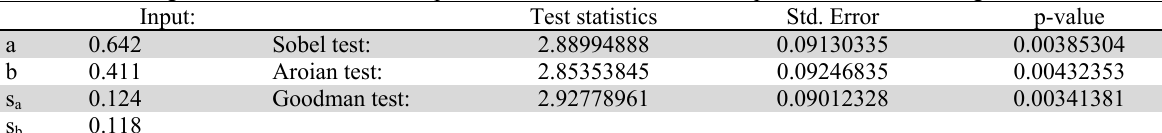
Result of mediating role of CRM in relationship between online trust and online purchase intention using Sobel Test